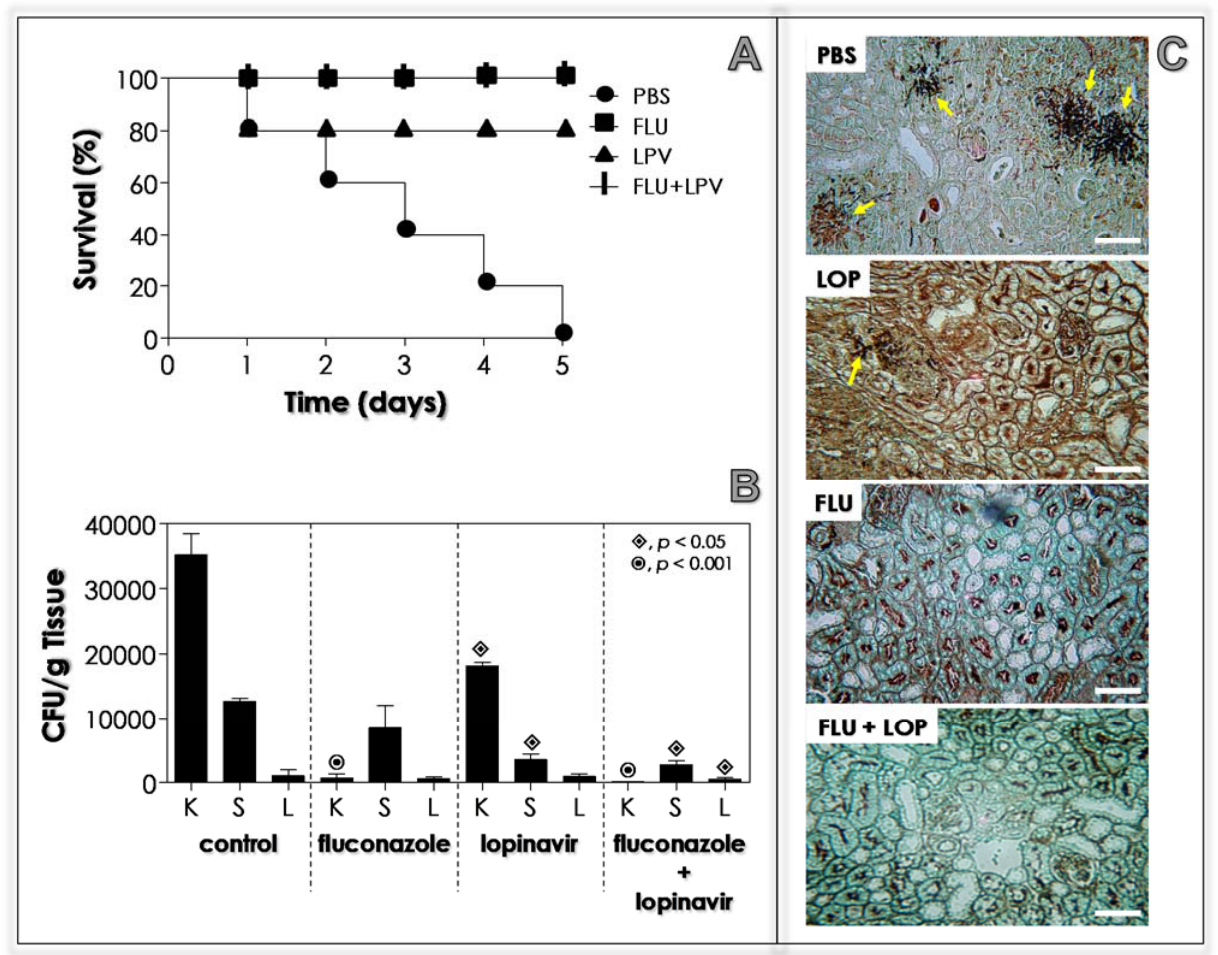
Figure 11. Effects of lopinavir on the in vivo infection of immunosuppressed mice with C. albicans . Six cyclophosphamide- immunosuppressed female BALB/c mice per group were intravenously infected with 10 5 yeasts. After 1 h, the animals were treated with PBS (control group), fluconazole (FLU; 10 mg/mL), lopinavir (LPV; 10 mg/mL) and a combination of both drugs at 10 mg/mL (FLU + LPV). ( A ) The mice survivability was evaluated every day during 5 consecutive days to construct a survival curve. ( B ) To evaluate the fungal burden, after 5 days post-infection, the animals were anaesthetized and euthanized, and then the kidneys (K), spleen (S) and liver (L) of the mice were dissected, weighed, homogenized in PBS and inoculated in BHI medium to evaluate the number of CFUs. Note: The time of animal death occurred throughout the day (some died in the morning, others in the afternoon or in the evening). In this context, the animals were checked